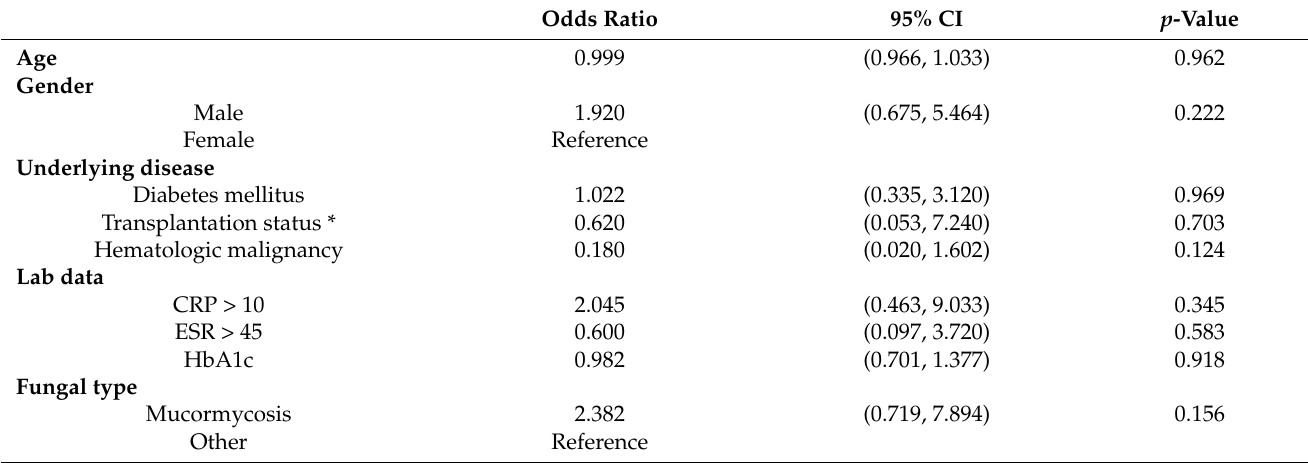
Table 7. Univariable logistic regression for factors predicting orbital complications in